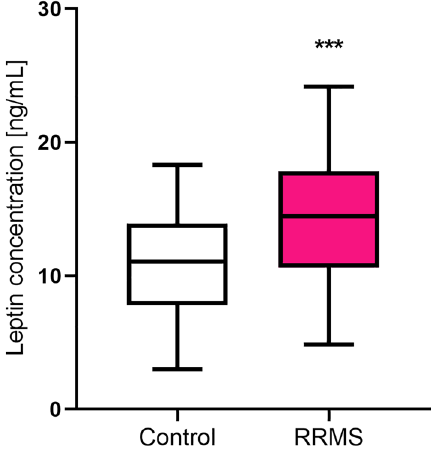
Figure 1. Plasma Leptin concentration in relapse-remitting multiple sclerosis patients (RRMS) as compared to the healthy control individuals. Statistical significance ***p ≤ 0.001.